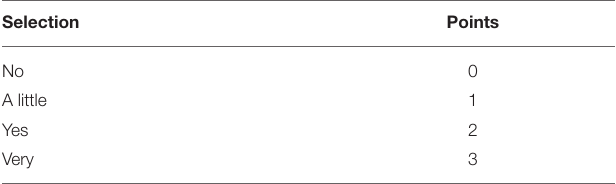
TABLE 2 | Questionnaire responses and